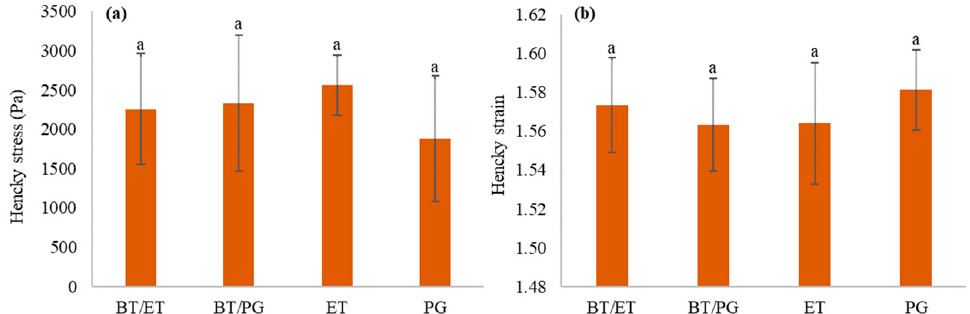
Figure 6. ( a ) Hencky stress and ( b ) Hencky strain of different hydrogels. Equal a,b letters in the same column indicate no statistically significant difference between the averages, assessed by the Tukey test at the 95% level of significance.